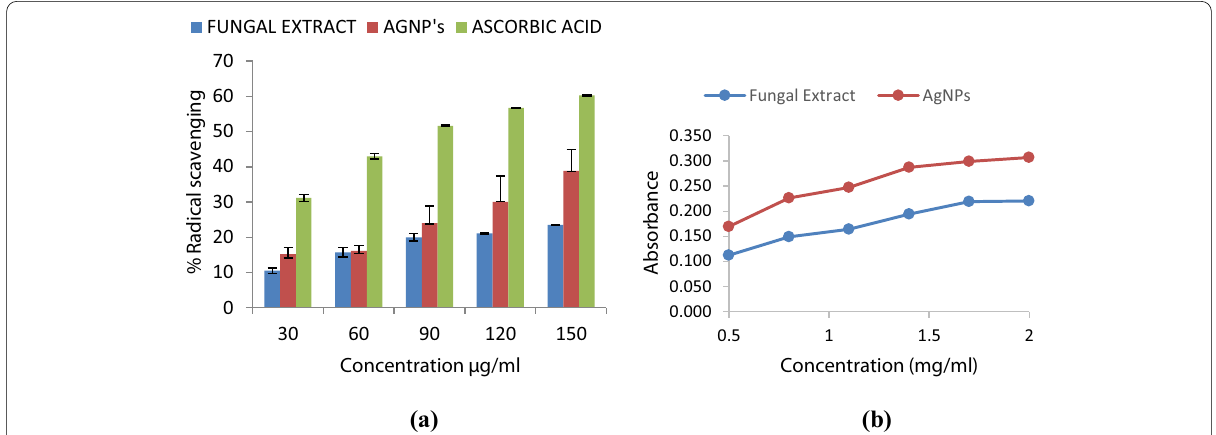
Fig. 9 Antioxidant assay. a DPPH Scavenging activity of T. purpureogenus mediated synthesized AgNPs. b Reducing power assay T. purpureogenus mediated synthesized